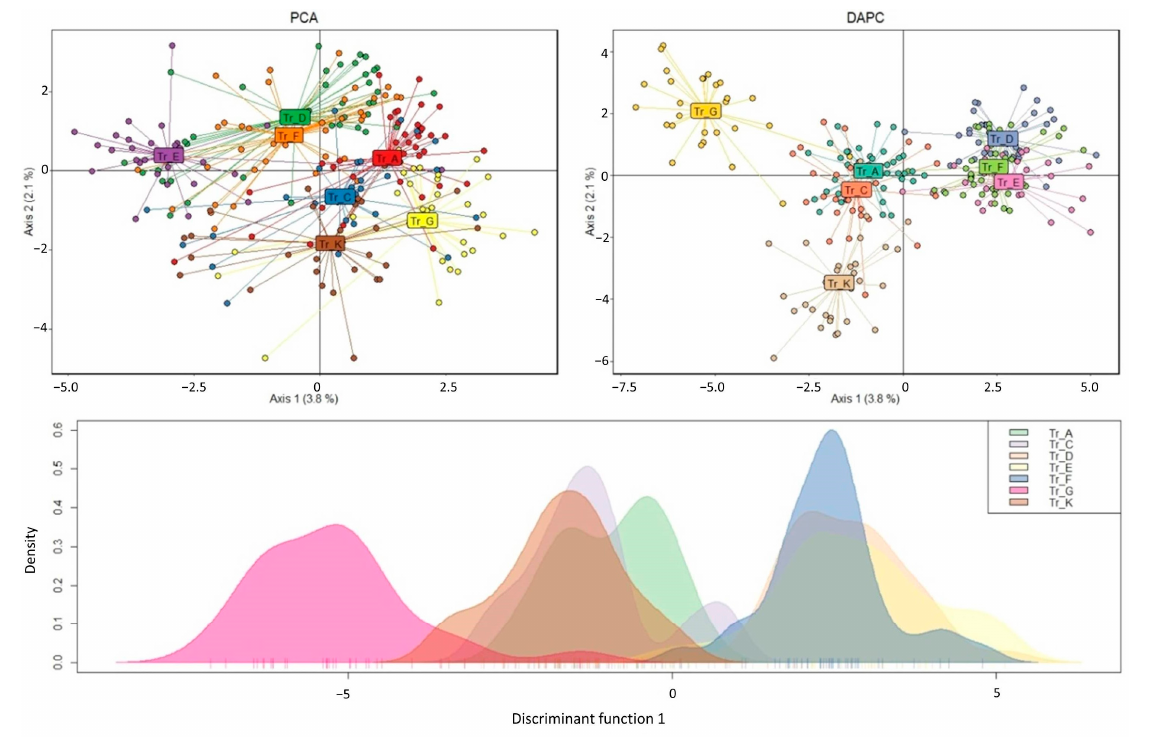
Figure 9. Results of principal component analysis (PCA, top left ) and discriminant analysis of principal components (DAPC, top right ), and plot of sample density along the first discriminant Int. J. Mol. Sci. 2023 , 24 , 4530 function ( bottom ).